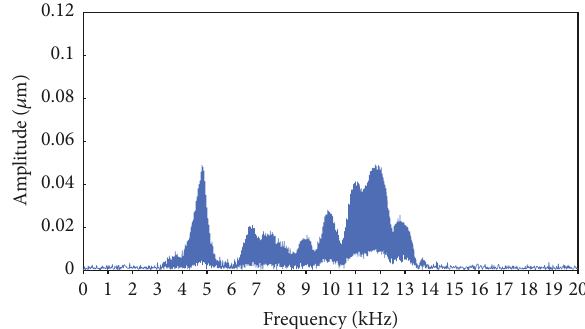
Figure 35: Spectrum of the original signal of a faulty gear (crack ratio = 25%).